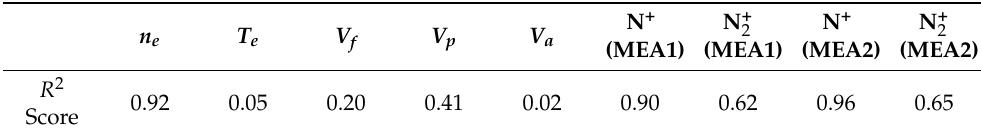
Table 2. Regression results between the OES data and nine plasma parameters measured in the PN-ICP